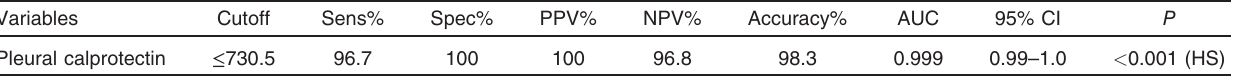
Table 4 Cutoff value, sensitivity, specificity, and positive predictive value of pleural calprotectin level in the prediction of malignant pleural effusion Variables Cutoff Sens% Pleural calprotectin ≤